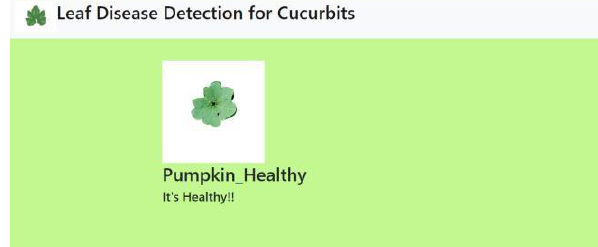
Fig 13. Suggestion for a healthy